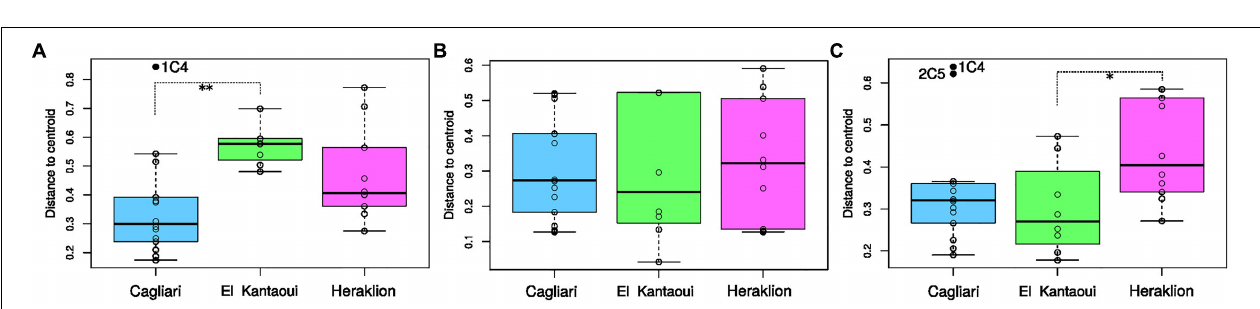
FIGURE 3 | Ordination plot resulting from non-metric multidimensional scaling (nMDS) based on Bray-Curtis dissimilarity in the T-RFLP profiles of bacterial 16S rRNA genes (A) , archaeal 16S rRNA genes (B) and dsrAB genes of SRB (C) in surface sediments of the three port areas. Blue: Cagliari; Green: El Kantaoui; Pink: Heraklion. The digit in the symbol identifies the sampling station within each port area.